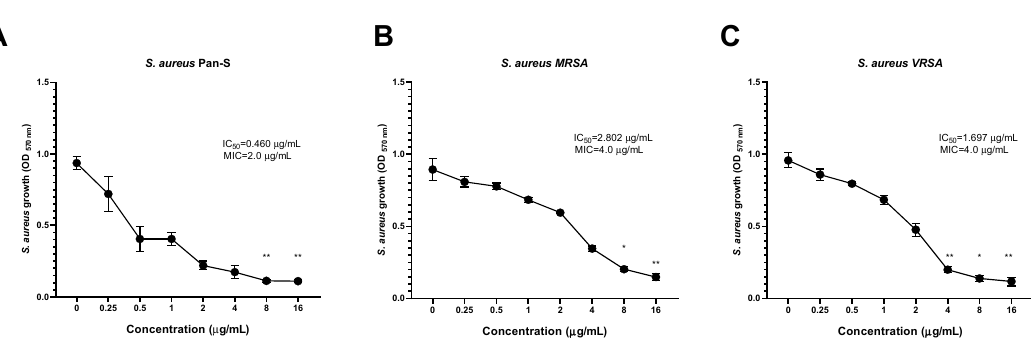
Figure 3. Concentration-dependent antibacterial activity of KTU-286 against Staphylococcus aureus with genetically defined resistance. Representative strains of pan-susceptible S. aureus ( blaZ ) ( A ), methicillin-resistant S. aureus (MRSA) (SC mecA, ermA ) ( B ), and VRSA ( vanA, aac(6 ′ )-aph(2 ″ ), tetK ) ( C ) were exposed to increasing concentrations of KTU-286 (0 – 16.0 µg/mL). The highest inhibitory activity of KTU-286 against S. aureus was also observed among pan-susceptible (Pan-S) S. aureus (IC 50 = 0.460 µg/mL), followed by VRSA (IC 50 = 1.697 µg/mL) and MRSA (IC 50 = 2.802 µg/mL). Data represent mean ± SD of triplicate experiments ( n = 3). Statistical differences were determined using Kruskal–Wallis test. * p < 0.05; ** p < 0.01.